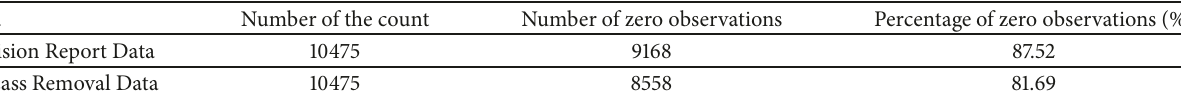
Table 4: The distribution of zero observations in the defined